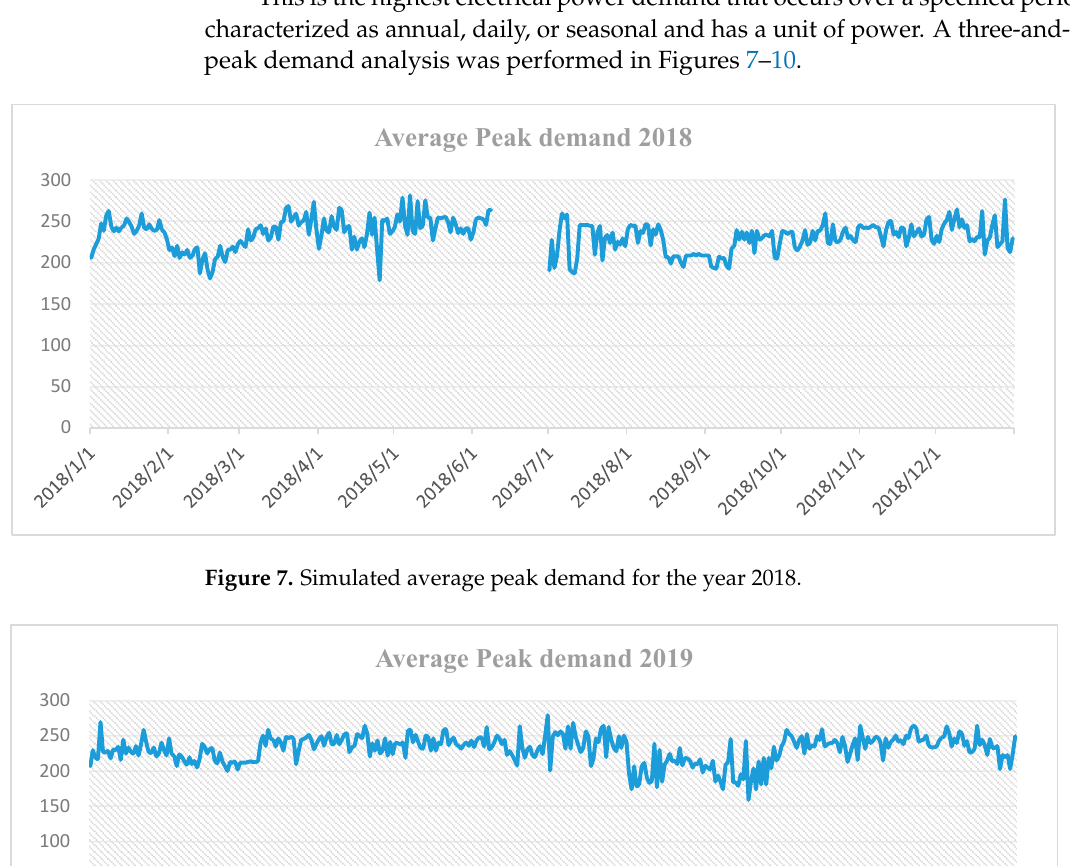
Figure 8. Simulated average peak demand for the year 2019.